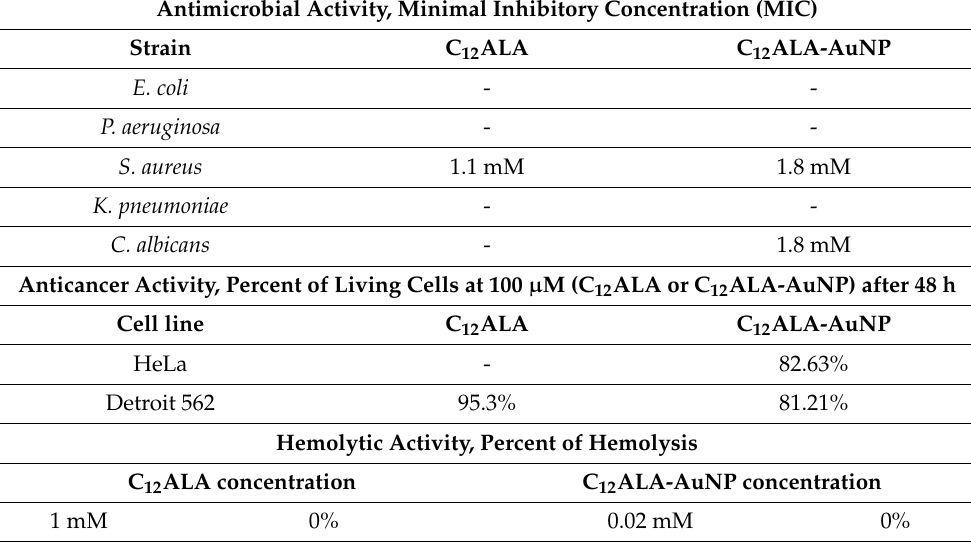
Table 1. Biological activity of C 12 ALA and C 12